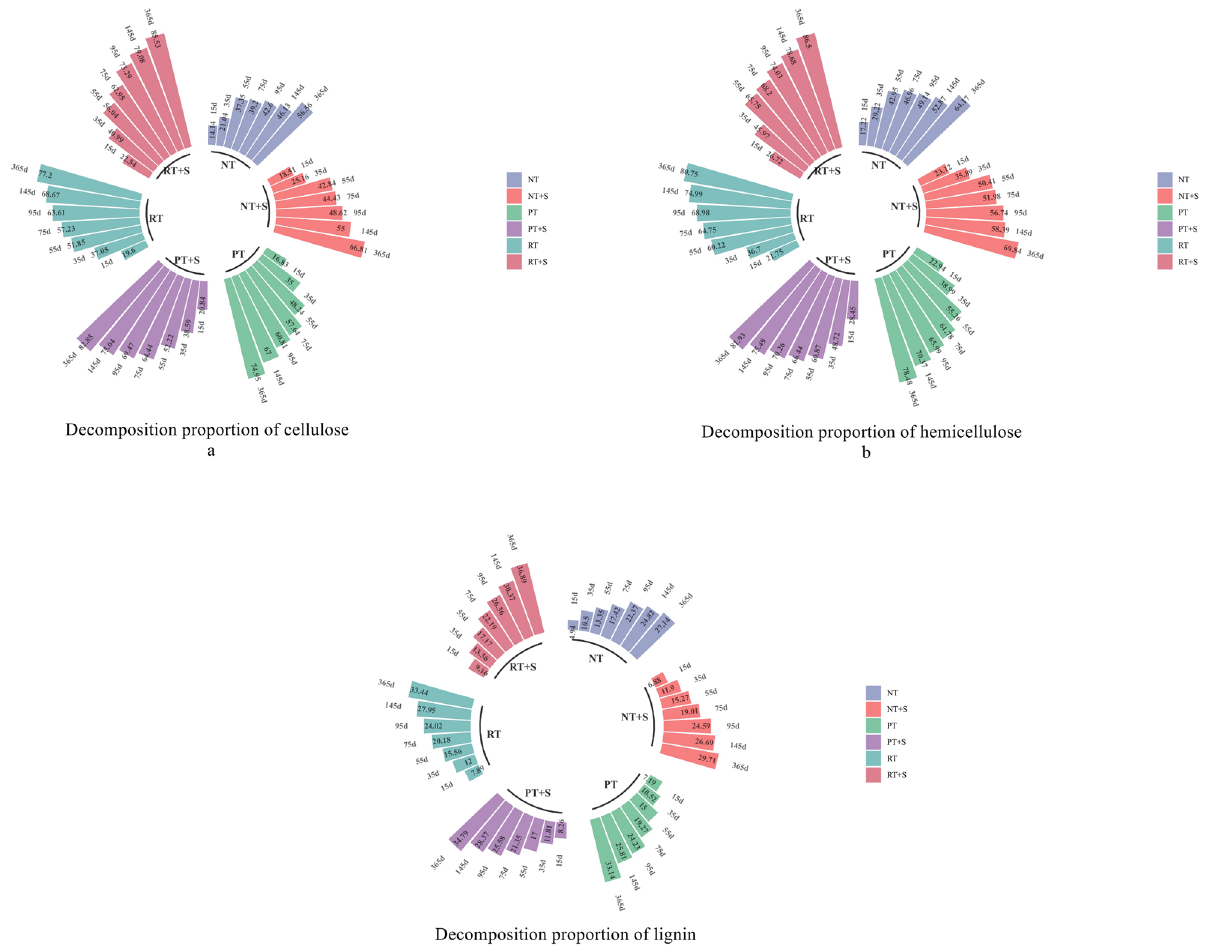
Figure 3. ( a – c ) are the circular barplots of the decomposition proportion of cellulose, hemicellulose and lignin in straw at 15, 35, 55, 75, 95, 145 and 365 days.